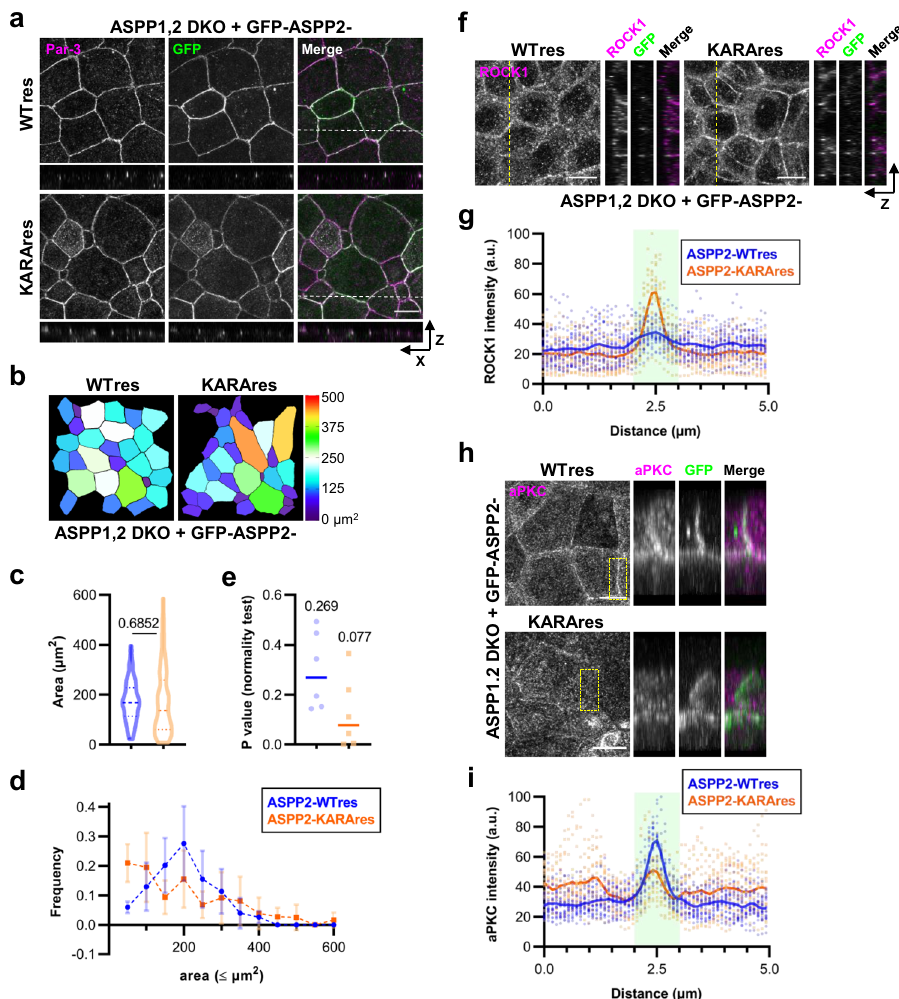
Fig. 4 Par-3 recruitment to AJC is insuf fi cient to downregulate ROCK in the absence of ASPP2-PP1 interaction. a Representative immuno fl uorescence images of GFP-ASPP2-WTres and GFP-ASPP2-KARAres cells stained for Par-3 (magenta). Scale bar, 10 μ m. b Pseudocolor representations of apical areas in GFP-ASPP2-WTres and GFP-ASPP2-KARAres cells. c Violin plot depiction of apical areas in GFP-ASPP2-WTres and GFP-ASPP2-KARAres cells. Data were collated from six measurements obtained over three independent experiments. Lines represent the median and the upper and lower quartiles. P value from unpaired t test is shown. n = 149 (WTres) and 139 (KARAres). d Frequency distributions of apical areas in GFP-ASPP2-WTres and GFP-ASPP2- KARAres cells. Data were as in c . Points are means and error bars are SDs. e P values of D ’ Agostino & Pearson test for normal distribution were computed from the data presented in d . Medians are notated and shown graphically as lines. f Representative immuno fl uorescence images of GFP-ASPP2-WTres and GFP-ASPP2-KARAres cells stained for ROCK1. Scale bar, 10 μ m. g Cross-junctional line scans of ROCK1 immuno fl uorescence from images corresponding to f . Shaded area represents AJC as de fi ned by GFP fl uorescence. Individual data from 20 independent line scans are shown with the means depicted by solid lines. h Representative immuno fl uorescence images of GFP-ASPP2-WTres and GFP-ASPP2-KARAres cells stained for aPKC. 3D projections of the region indicated by the yellow dotted square are shown to the right. Scale bar, 10 μ m. i Cross-junctional line scans of aPKC immuno fl uorescence from images corresponding to h . Shaded area represents AJC as de fi ned by GFP fl uorescence. Individual data from 20 independent line scans are shown with the means depicted by solid lines. Source data are available in Supplementary Data